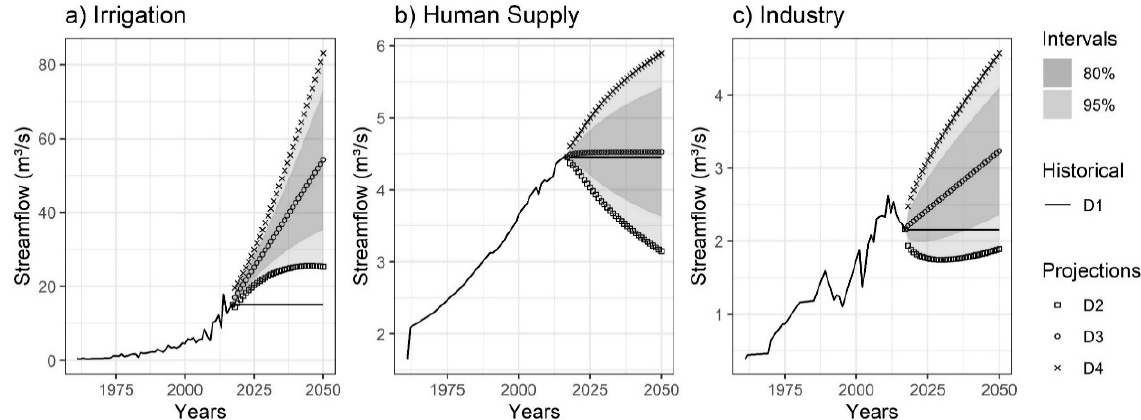
Figure 13. Scenarios of the projections of annual consumptive demands on the Três Marias reservoir using the ETS model for the period 2018 to 2050.